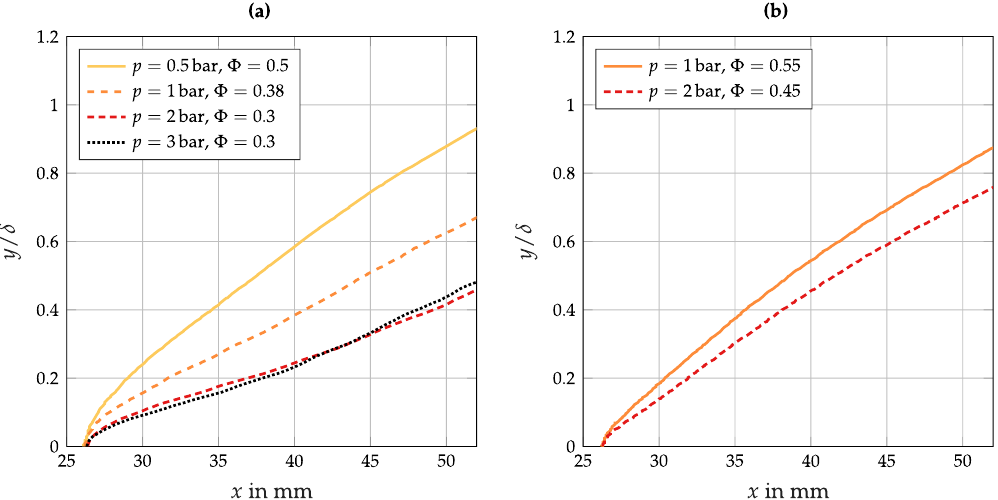
Figure 9. Comparison of average stable flame shapes at different pressure levels evaluated at c = 0.5.